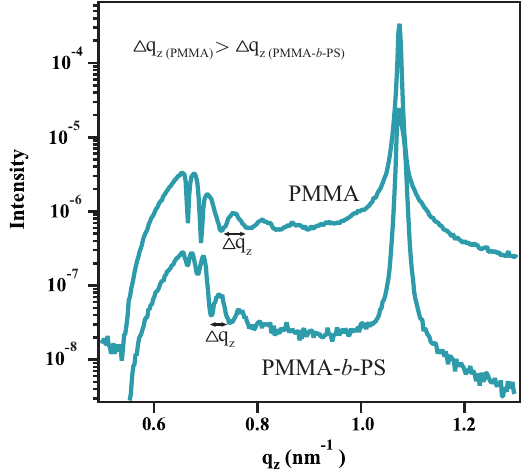
Figure 13. GISAXS line cuts in q z -direction of PMMA brushes and PMMA- b -PS diblock copolymer brushes. The distance between two oscillation minima in the PMMA brushes ( ∆ q z ) is higher than in copolymer brushes, which is an indicator for a lower layer thickness of PMMA